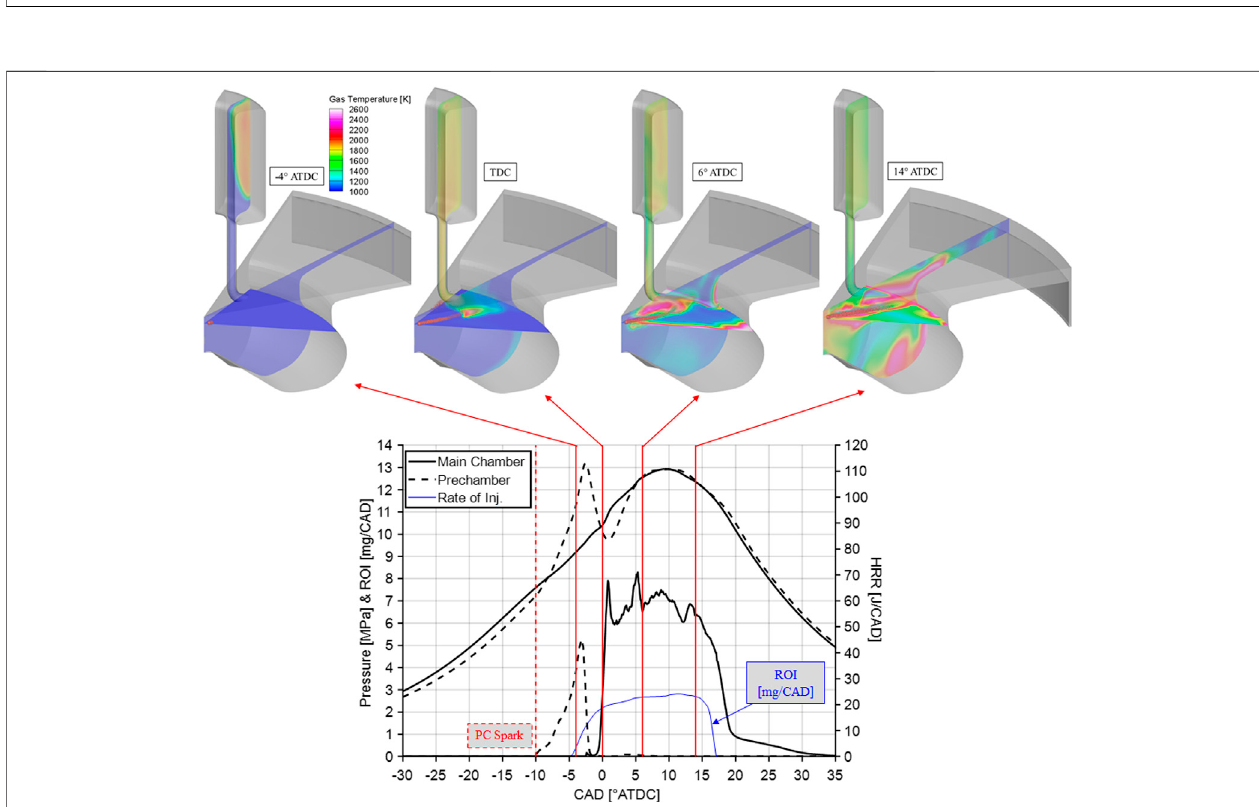
FIGURE 7 | Prechamber enabled mixing controlled combustion (PC-MCC) operated on pure methanol. Prechamber height (H pc ) of 20 mm and passageway diameter (D pass ) of 1.5 mm. Prechamber spark timing of -10 ° ATDC and DI-SOI methanol of -4.9 ° ATDC.